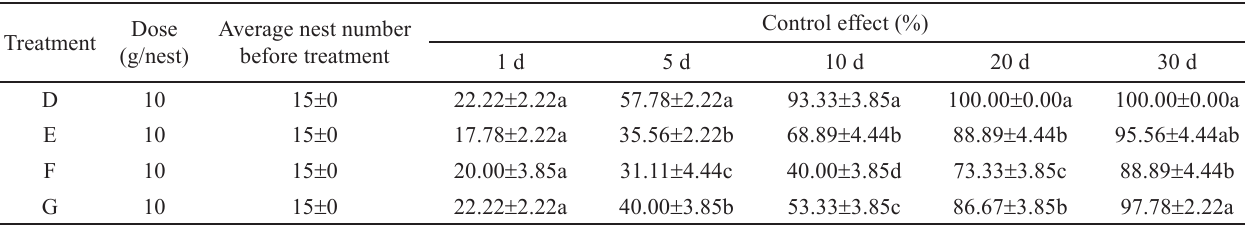
Table 6 . The control effect of rotenone-based bait on